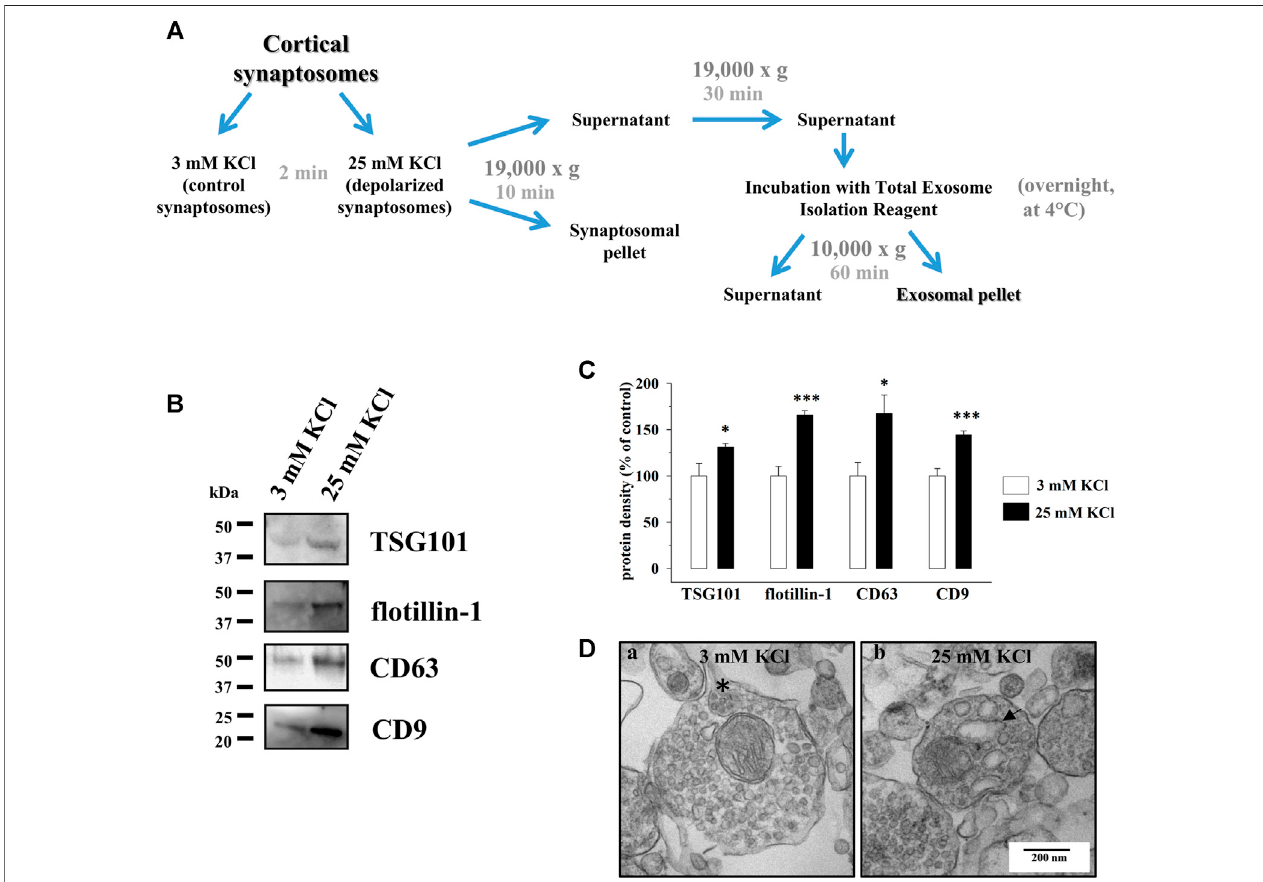
FIGURE2| CorticalsynaptosomesreleaseextracellularvesiclesimmunopositivefortheexosomalmarkersTSG101, fl otillin-1,CD63,andCD9,andtheirsecretion isincreasedbydepolarization. (A) Schematicrepresentationoftheisolationprocedureoftheexosomesfromthesupernatants ofthesynaptosomesincubatedfor2 min in 3 mM KCl medium (control synaptosomes) or in 25 mM KCl medium (depolarized synaptosomes). For further details, see the Methods section. (B) Western blot analysis of TSG101, fl otillin-1, CD63, and CD9 proteins in the exosomal fractions isolated from the supernatants of the control (lane 3 mM KCl) and depolarized synaptosomes (lane 25 mM KCl). The image is representative of the results of n (cid:1) 5 (TSG101), n (cid:1) 6 (CD63), and n (cid:1) 11 ( fl otillin-1 and CD9) Western blot analyses. (C) Quanti fi cation of the change in TSG101, fl otillin-1, CD63, and CD9 proteins in the exosomal fraction from the supernatants of depolarized synaptosomes (25 mM KCl, black bars) when compared to the control synaptosomes (3 mM KCl, empty bars). Results are expressed as percent of control (3 mM KCl). Data represent the mean ± SEM. * p < 0.05 vs. respective control; *** p < 0.001 vs. respective control. (D) Ultrastructural analysis of the control and depolarized cortical synaptosomes by TEM. The fi gureshowsarepresentativeimageofsynaptosomesincubatedfor2 minin3 mMKClmedium(a)andin25 mMKClmedium(b).Asterisk,MVB-likeorganelleincontrol synaptosomes; arrow, endosomal-like organelle in depolarized synaptosomes. Scale bar: 200 nm. The image is representative of n (cid:1) 5 different synaptosomal